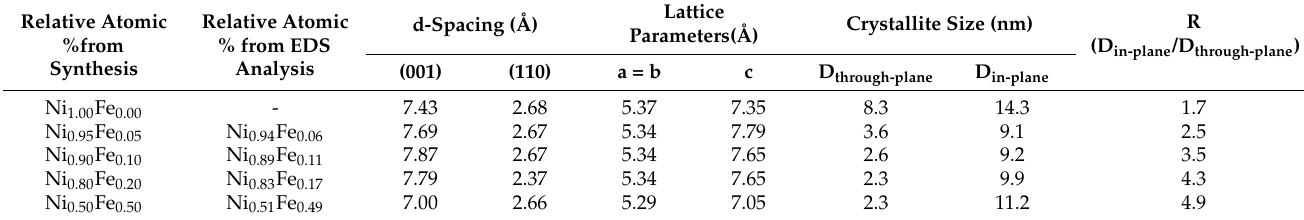
Table 1. Elemental composition and crystallographic properties of Fe-substituted nanosheets ob- tained by energy dispersive X-ray spectroscopy (EDS) and X-ray diffraction analysis. Within Ni 0.50 Fe 0.50 , the lattice parameters of the α -phase are included; D through-plane is the nanocrystalline grain size determined from the (001) planes; D in-plane is the crystalline grain size determined from the (110) planes; R(D in-plane /D through-plane ) is the ratio of the D in-plane/ D through-plane; details are provided in the text.